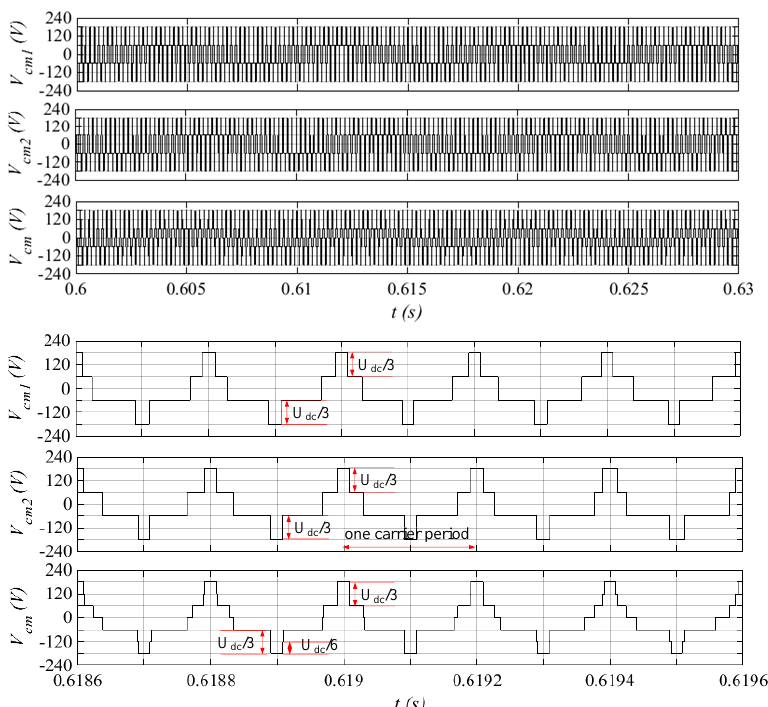
Figure 7. Simulation results of CMV for the DZIPWM strategy: two sub-CMVs V cm 1 and V cm 2 , total CMV V cm .